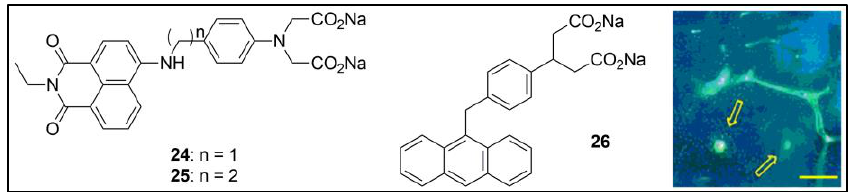
Figure 25. Structures of PET sensors 24 – 26 . Transverse section of the bone labeled with 24 , viewed in UV epifluorescence (365 nm); yellow arrow shows osteons with its lacunae, Haversian canal, and canaliculi. Bar = 100 μm. Adapted with permission from [ 98]. Copyright (2009) Elsevier.